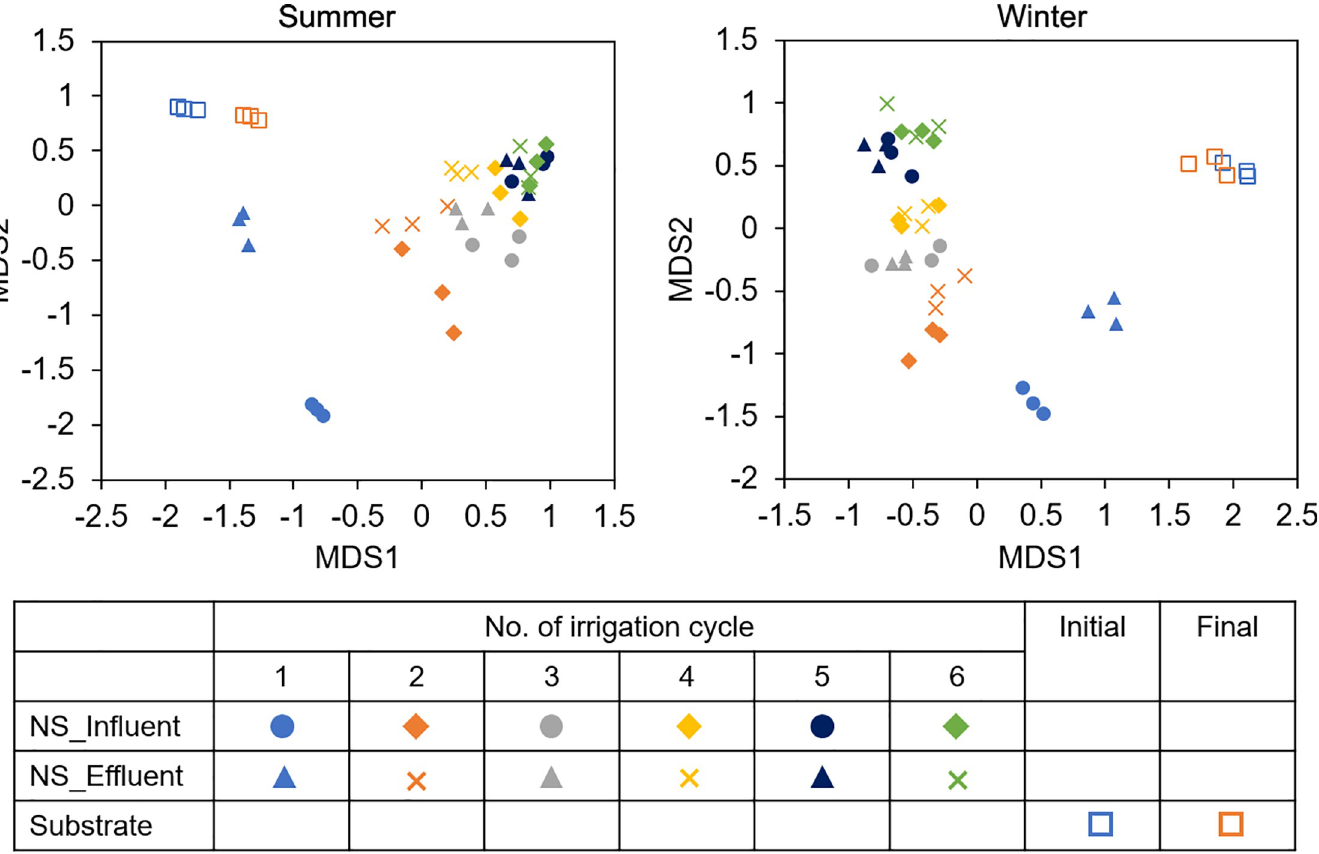
Fig 3. NMDS plots for Bray-Curtis distances of bacterial communities in the recirculating nutrient solution and substrate of cucumber plug seedlings cultivated in an ebb-and-flow system.